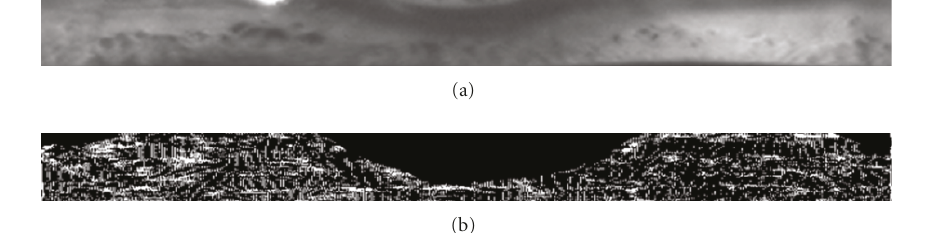
Figure 18: (a) shows an example of an iris plane that is obtained by unwrapping the iris region. The area occupied by the sclera is the U-shaped structure along the top of the rectangular image and at the top corners of the image. (b) shows the number of pixels in this image that were matched with a query iris image belonging to the same